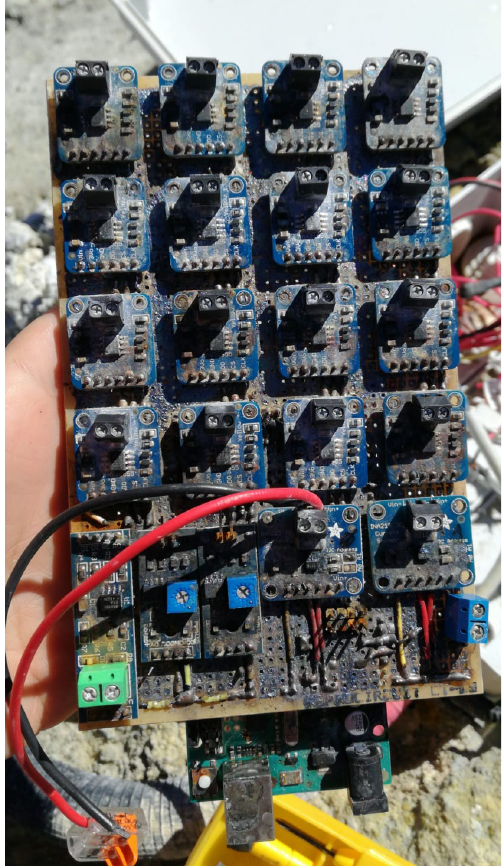
Figure 14. Corroded Printed Circuit Board (PCB) after one month of operation under volcanic conditions at